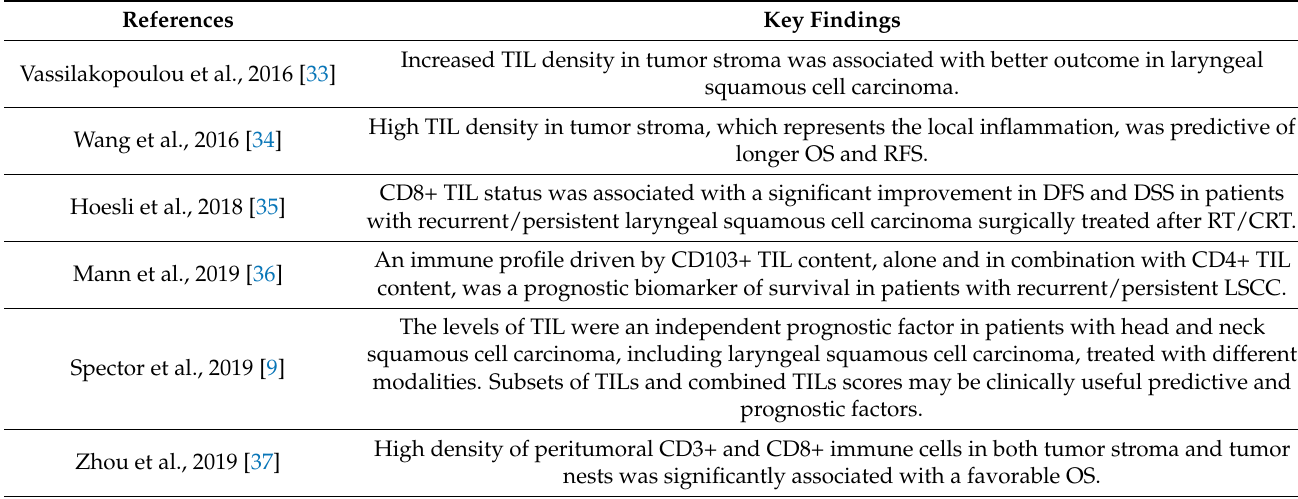
Table 2. Key findings of the selected